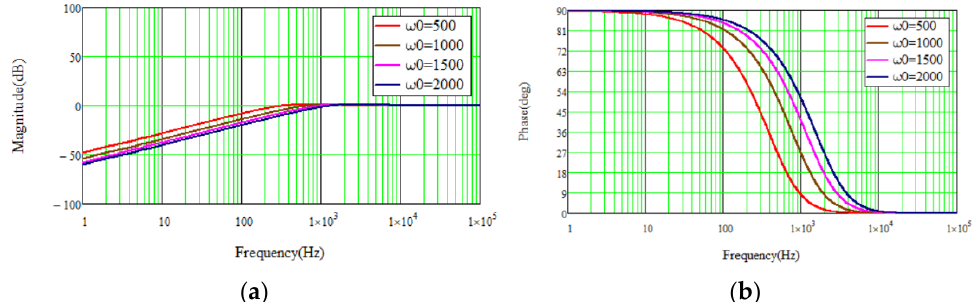
Figure 5. The magnitude and phase frequency curves of φ xe 2 − f . (a) Magnitude. (b) Phase. From Equations (10) and (11), the generalized perturbation can be obtained as shown in Equation